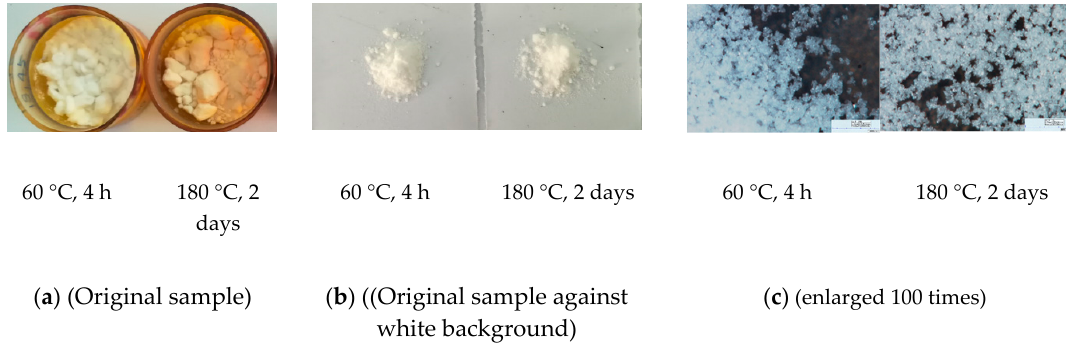
ff erent temperature tests.